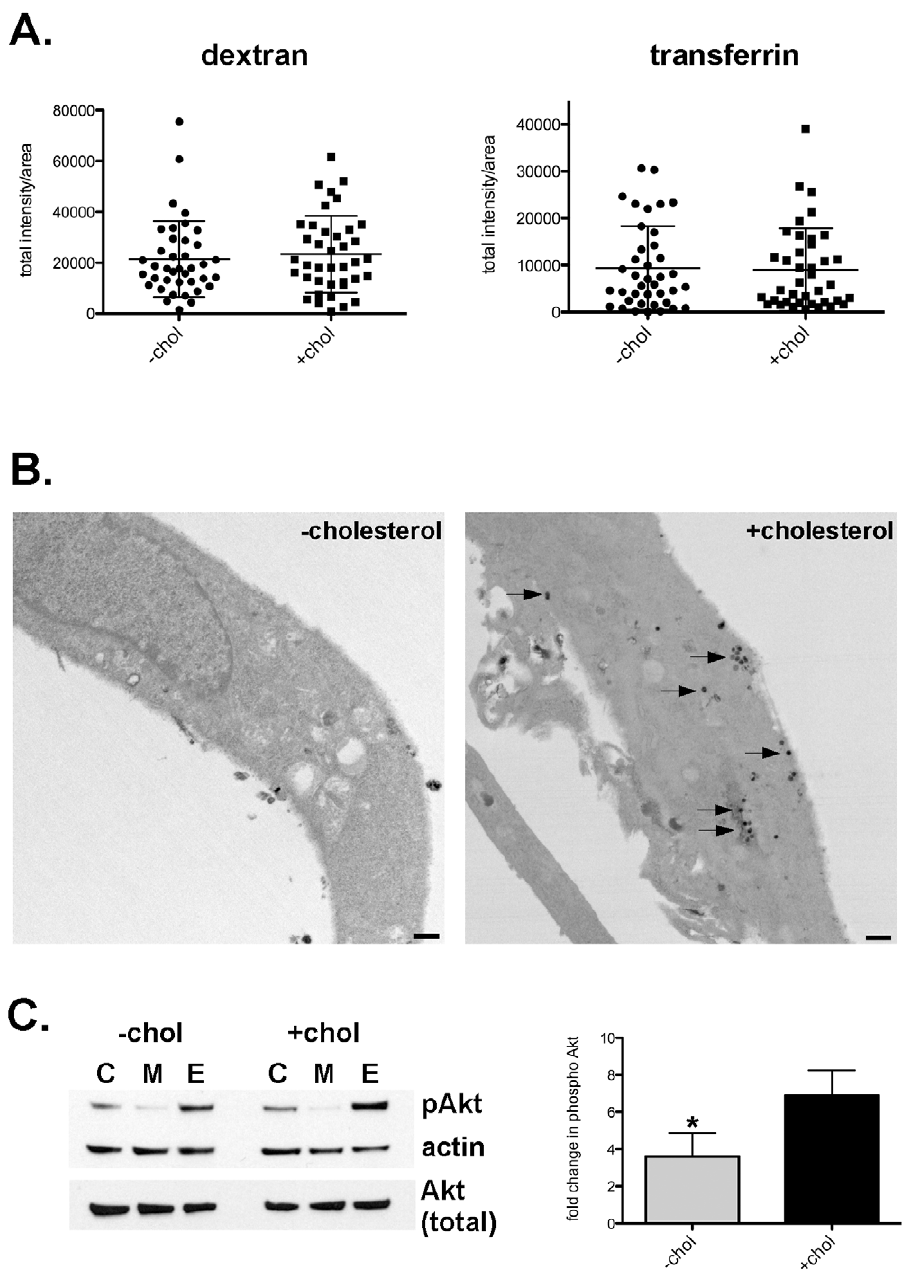
Figure 2. Lipid raft function is compromised in 2 cholesterol MEFs. (A). Scatter plot of semi-quantitative measurement of fluorescent dextran (fluid-phase) and transferrin (non lipid-raft) uptake. Each point represents the mean fluorescence intensity of an individual cell. Measurements for two independent experiments are shown with the mean and standard deviation indicated. No significant difference was found between 2 cholesterol and + cholesterol MEFs. (B). Representative transmission electron micrographs showing deficient uptake of cholera toxin-B (CT-B) in 2 cholesterol MEFs. Horseradish peroxidase (HRP)-labeled CT-B was added to cells and visualized by immunohistochemistry through the conversion of diaminobenzidine by HRP. In 2 cholesterol MEFs, very little to no CT-B-positive endosomes were observed, in contrast to + cholesterol MEFs (arrows). Scale bar=500 nm. (C) Phosphorylation of Akt. (Left panel) Representative immunoblot of MEF lysates probed for Akt phosphorylated at Ser473, total Akt, and ß-actin as a loading control. C, control MEFs; M, serum starved MEFs; E, serum starved MEFs treated with epidermal growth factor (EGF) for 2 min. (Right panel) Densitometry of immuoblot showing that EGF stimulation resulted in a 6.9 + / 2 0.73 fold increase in Akt (Ser473) phosphorylation by + cholesterol MEFs, but only a 3.6 + / 2 0.78 fold increase by 2 cholesterol MEFs (p=0.0373), indicating signaling through lipid rafts is impaired in 2 cholesterol MEFs. The mean + / 2 SD of three independent experiments is shown. doi:10.1371/journal.ppat.1003107.g002 densitometry was used to measure phosphorylated Akt after EGF to + cholesterol MEFs (Figure 2C). Collectively, our data indicate stimulation. There was a 50% reduction (p = 0.0373) in phos- that lipid raft function is significantly impaired in 2 cholesterol phorylated (activated) Akt in 2 cholesterol MEFs when compared MEFs.